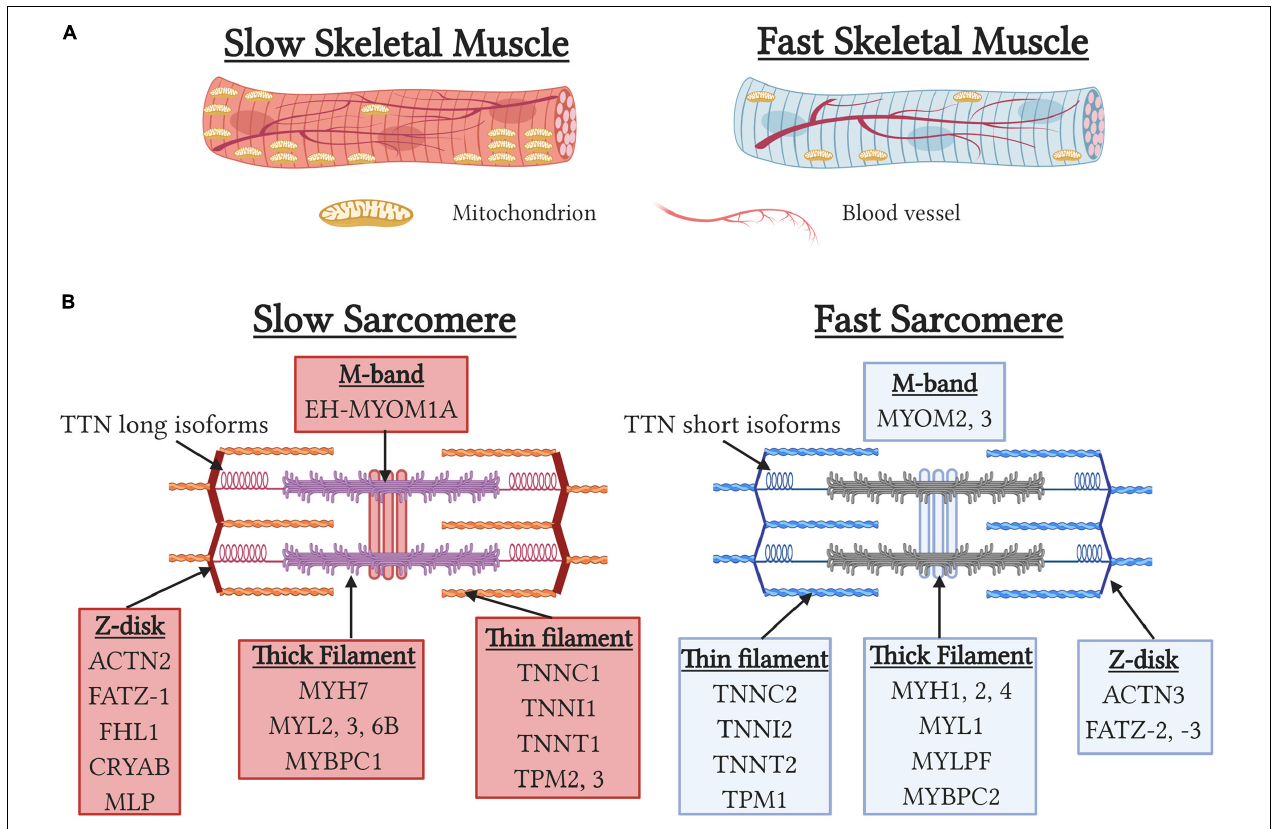
FIGURE 2 | Structural differences between slow and fast-fiber type muscles. (A) Schematic depicting gross morphological differences between slow and fast skeletal muscles. Note the higher levels of mitochondria and capillary density associated with slow skeletal muscles. (B) Sarcomeric gene specialization and enrichment in slow and fast